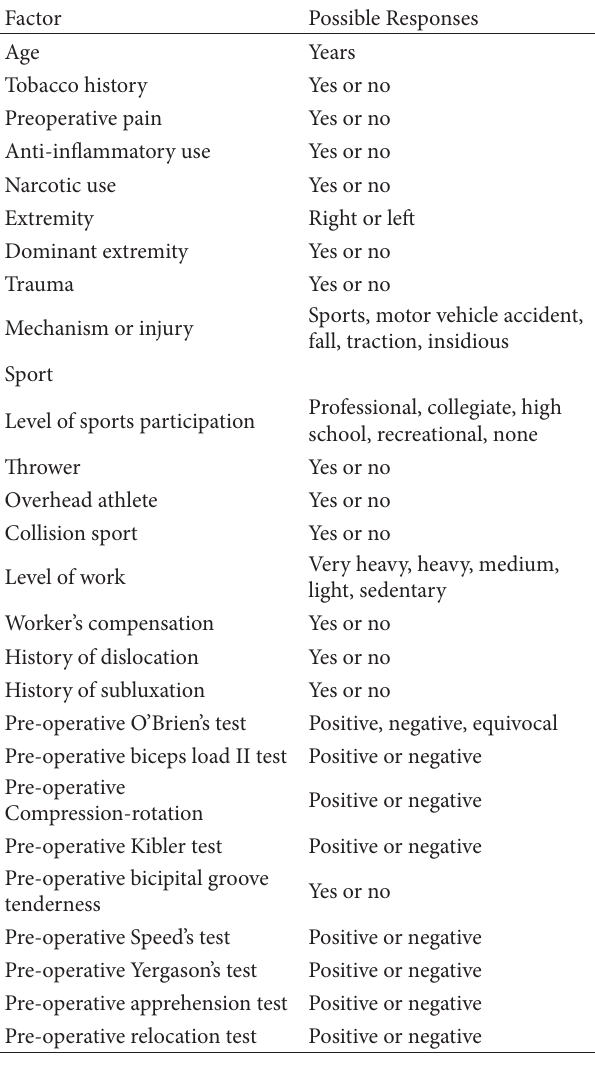
Table 1: Prognostic factors asked on post-operative